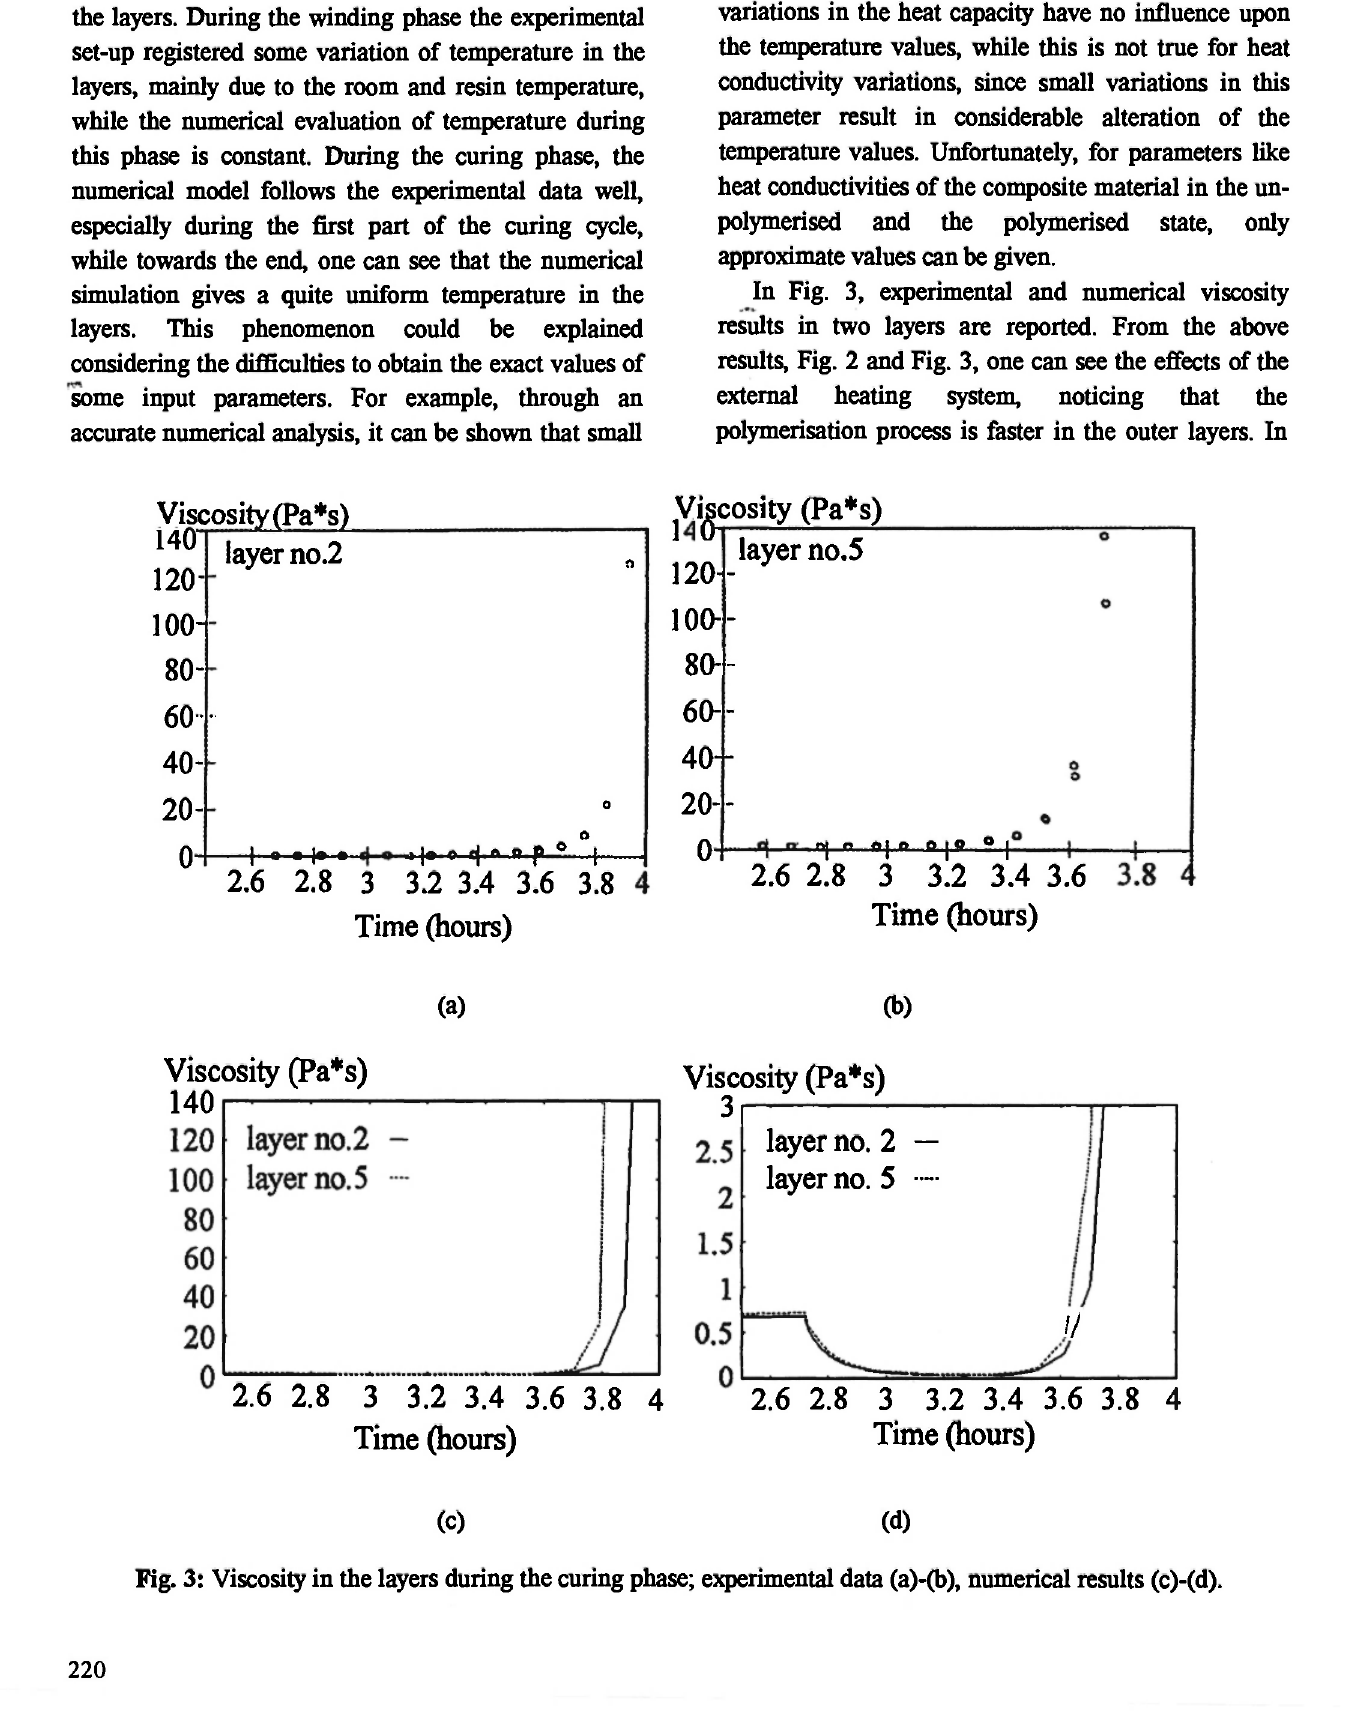
Fig. 3: Viscosity in the layers during the curing phase; experimental data (a)-(b), numerical results (c)-(d).